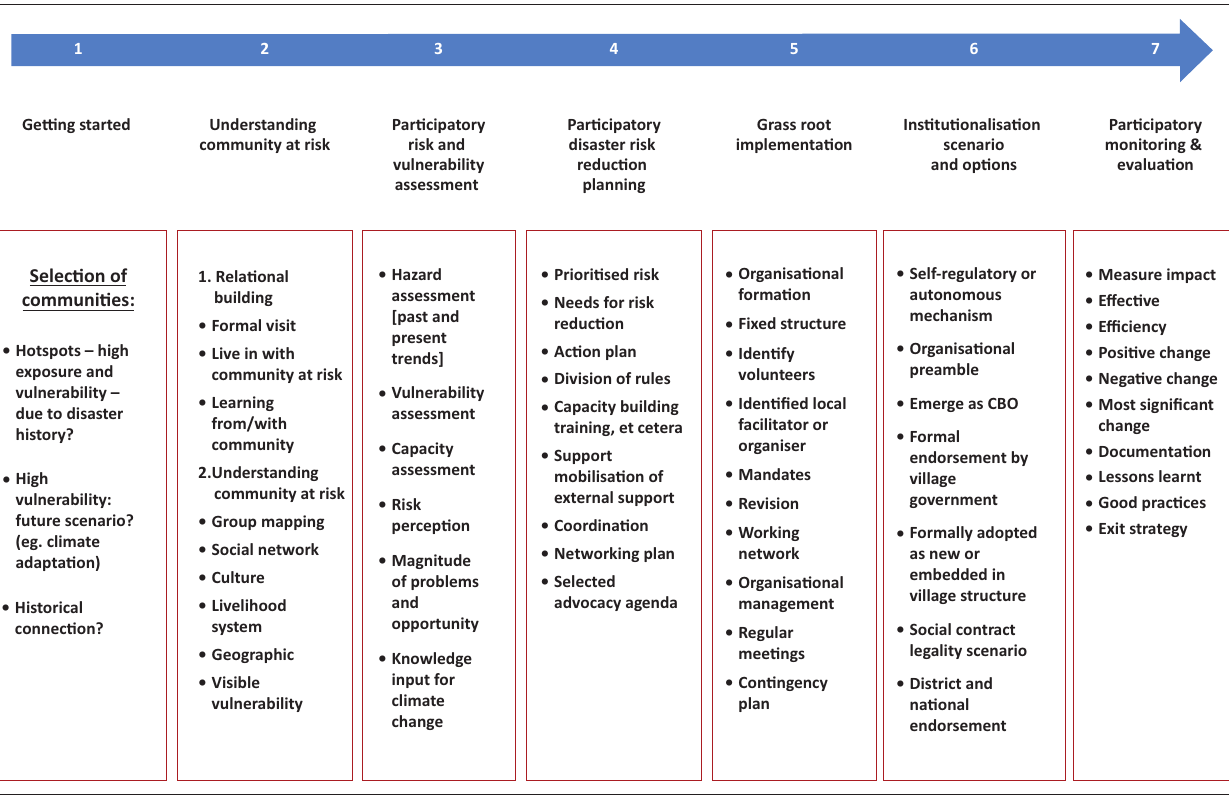
FIGURE 1: Processes and tools of community-based disaster risk reduction frameworks.